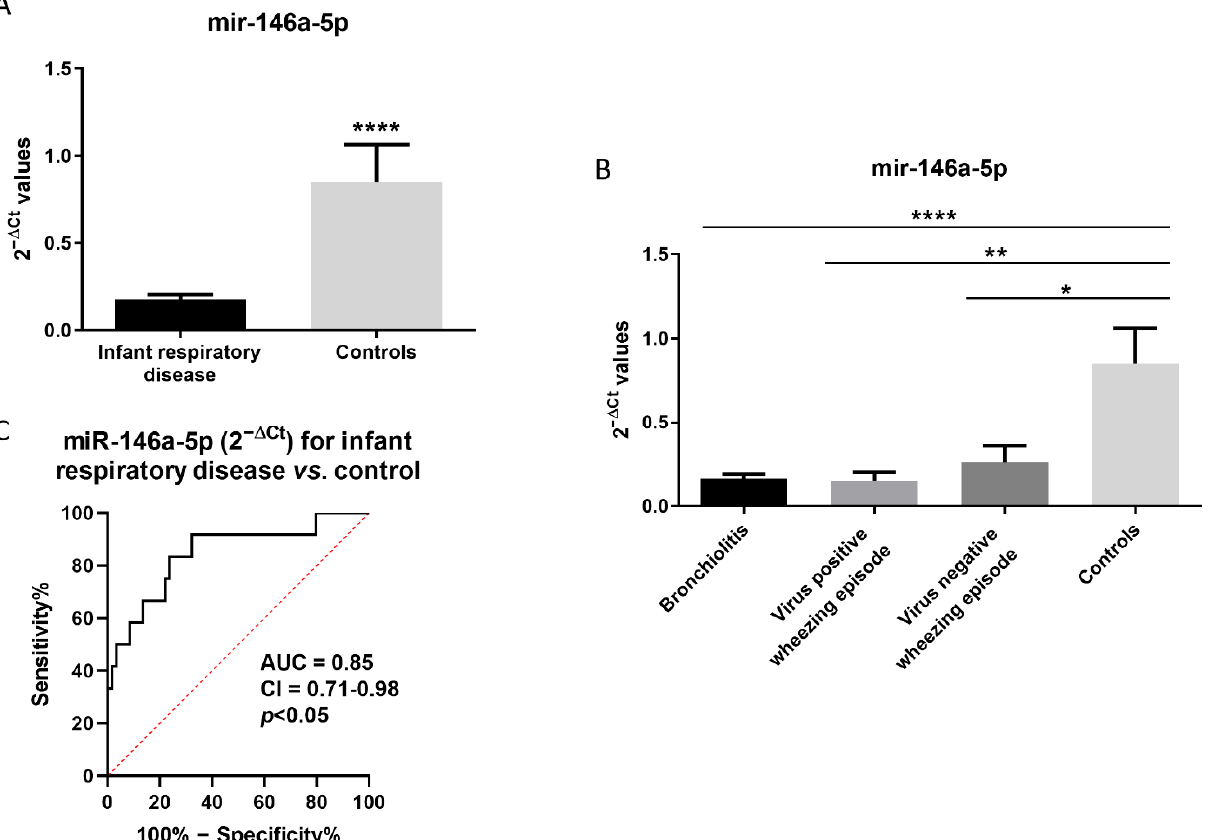
Figure 1. miR-146a-5p is altered in NPA samples from infant respiratory diseases. ( A ) miR-146a-5p expression (2 − ∆ Ct ) in infant subjects with respiratory disease and controls. ( B ) miR-146a-5p expression (2 − ∆ Ct ) in patients with bronchiolitis, virus-positive patients with wheezing episodes, virus-negative subjects with wheezing episodes, and controls. ( C ) ROC curve for miR-146a-5p expression (2 − ∆ Ct ) as a biomarker for infant respiratory diseases. AUC = area under the curve; CI = confidence interval. * p < 0.05; ** p < 0.01; **** p < 0.0001.